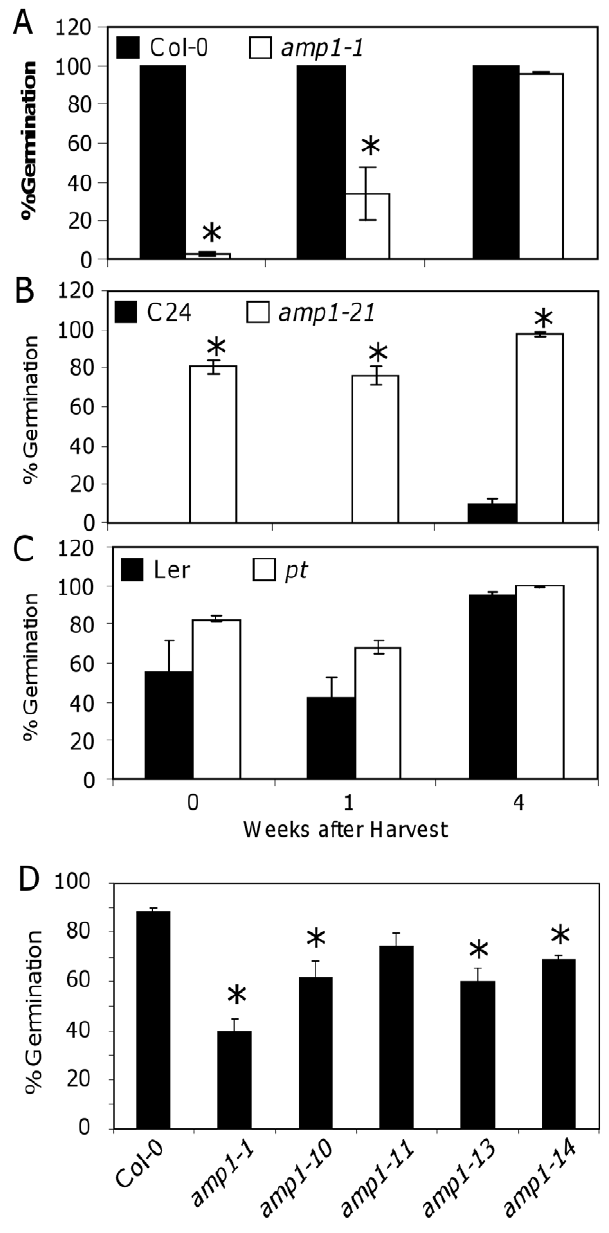
Figure 3. Dormancy phenotypes of amp1 mutants. (A) % Germination seven days after sowing of bulk harvested Col-0 and amp1-1 (A), C24 and amp1-21 (B) and L er and pt (C) after-ripened for the indicated time. (D) Germination of all amp1 mutant alleles in Col-0 background freshly-harvested seeds. Means of three biological repli- cates with their SE are shown. *Statistically significant difference in a Student’s t-test (P , 0.05; n =3).